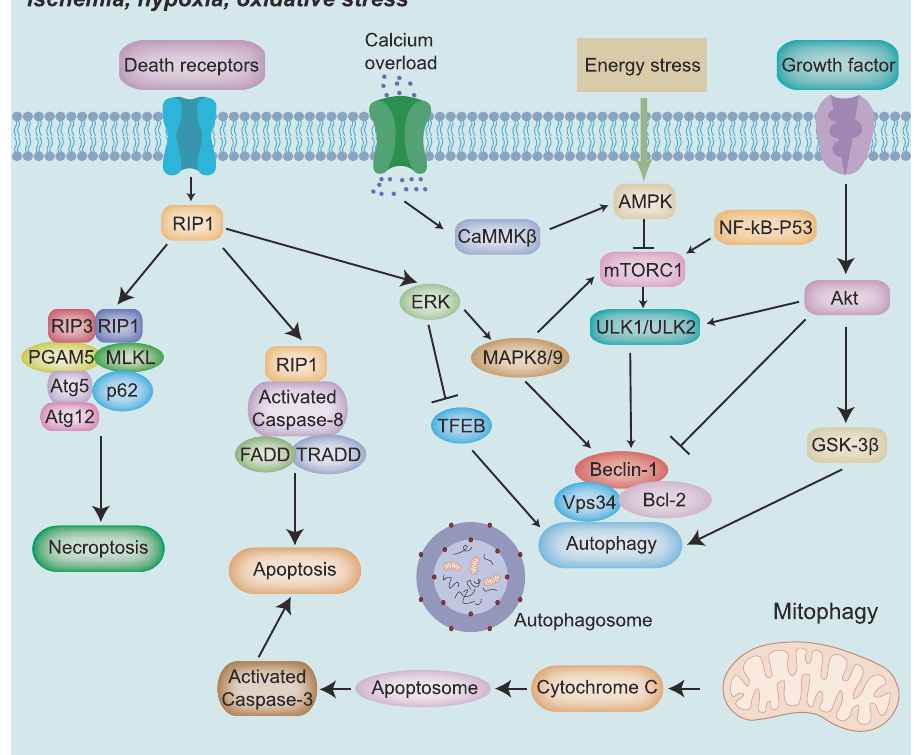
Fig. 5 Cell death signaling pathways involved in ischemic stroke. GSK3 β Glycogen synthase kinase-3 β ; Bcl-2 B-cell lymphoma-2; ERK Ras/ extracellular signal-regulated kinase; CAMKs Ca 2 + /calmodulin-dependent protein kinases; MAPK Mitogen-activated protein kinase; TNF Tumor necrosis factor; mTOR mammalian target of rapamycin; AMPK 5 ′ -AMP-activated protein kinase; FADD Fas-associating protein with a novel death domain; TRADD TNFRSF1A Associated Via Death Domain; RIPK Receptor-interacting protein kinase; MLKL Mixed lineage kinase domain- like protein; RIP1 Receptor interaction protein 1; RIP3 Receptor interaction protein 3; PGAM5 Phosphoglycerate Mutase Family Member 5; MLKL mixed lineage kinase domain like pseudokinase; Atg5 Autophagy related 5; Atg12 Autophagy related 12; TFEB Transcription factor EB; ULK1 Unc-51 Like Autophagy Activating Kinase 1; AMPK 5 ′ -AMP-activated protein kinase; mTOR mammalian target of rapamycin; Apaf-1 Apoptotic peptidase activating factor